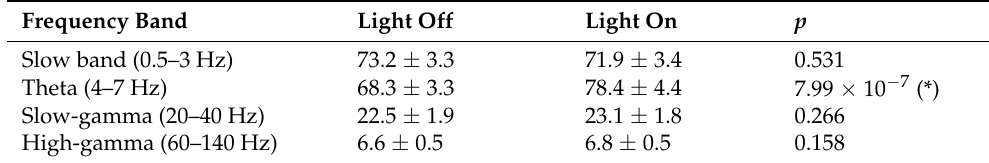
Table 1. Changes induced by light in hippocampal LFP rhythms. Frequency Band Light Off Light On p